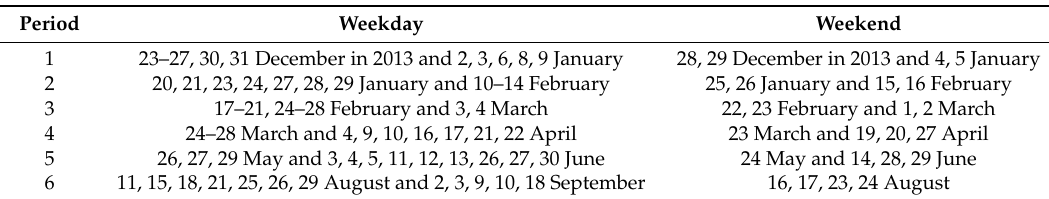
Table 2. Sampling days for each